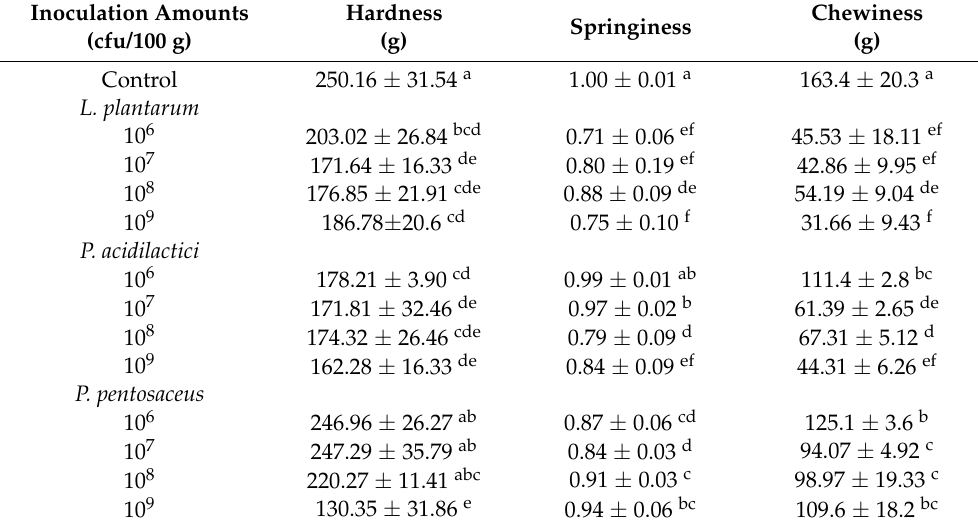
Table 1. Textural properties of Zhayu samples prepared by spontaneous fermentation (Control) and different inoculation amounts of L. plantarum , P. acidilactici , and P. pentosaceus